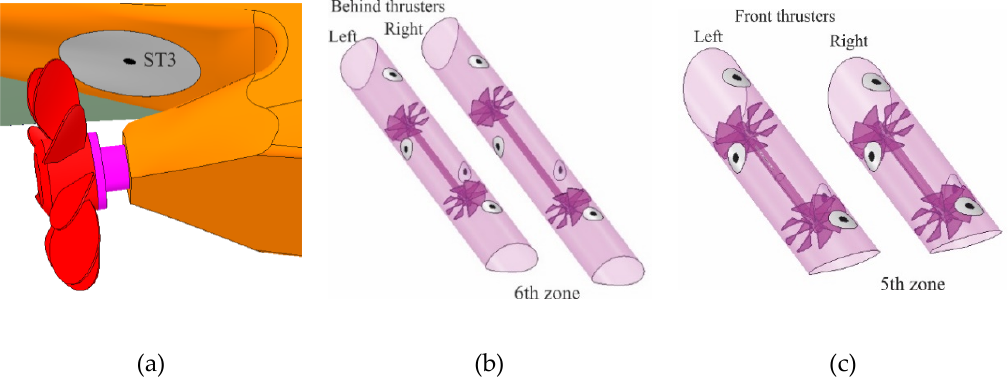
Figure 6. Details of installed anodes. ( a ) ST3 anode of the fourth zone at the stern ( b ) The sixth zone behind the thrusters and ( c ) the fifth zone in front of the thrusters. Black and grey areas represent anode and insulated areas, respectively.